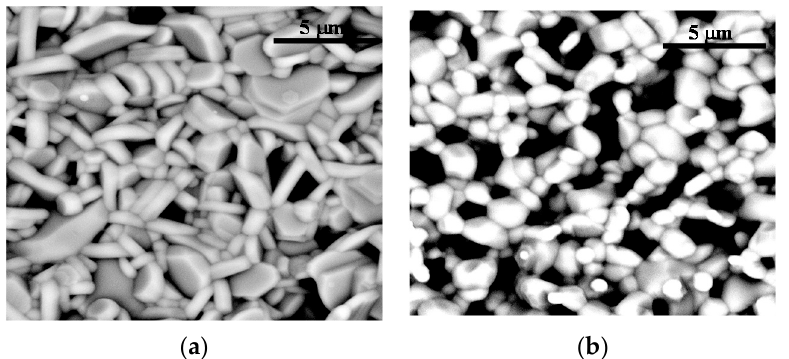
Figure 5. The SEM of the La x Sr 1- x Fe 12-2 x O 19 calcined powders with two different particle sizes of SrCO 3 as the raw material: ( a ) coarse-particle SrCO 3 , ( b ) fine-particle SrCO 3